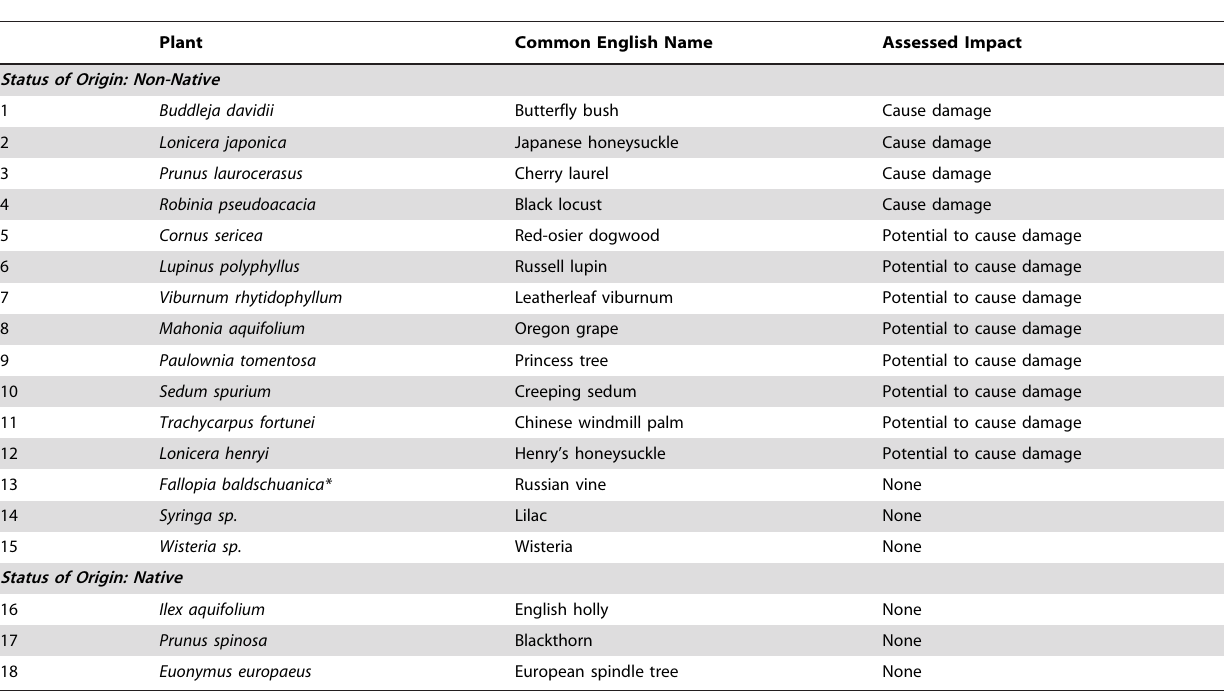
Table 1. Description of the ornamental plant species used in this study.